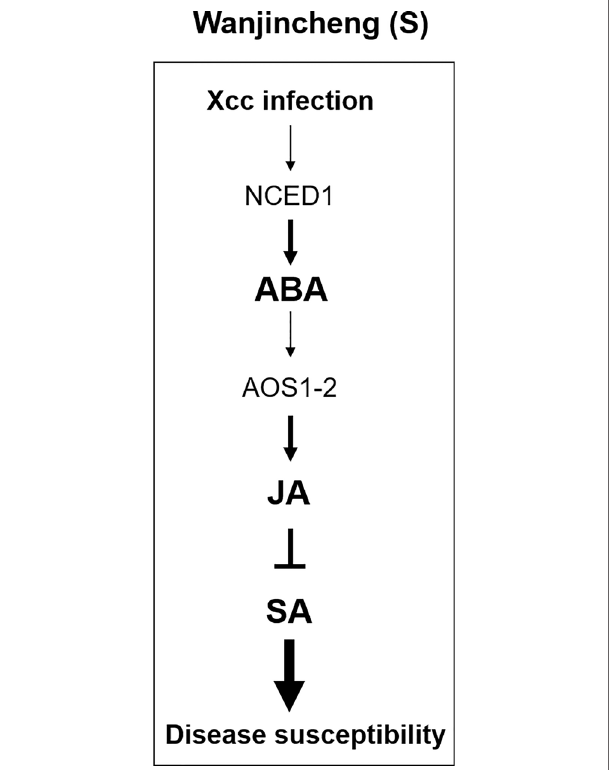
FIGURE 9 | Model for the interplay among JA, SA, and ABA in Wanjincheng orange (S) during infection with Xcc. The infection of the leaves with Xcc leads to an increased ABA accumulation through NCED1 in Wanjincheng orange (S). The high ABA content in susceptible citrus promotes JA synthesis through the ABA-responsive AOS1-2, which in turn antagonizes the effectual SA-mediated defenses to promote canker disease